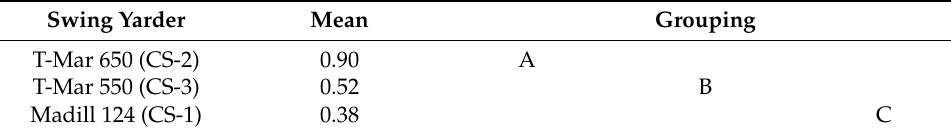
Table 3. Comparison of means using the Fisher LSD